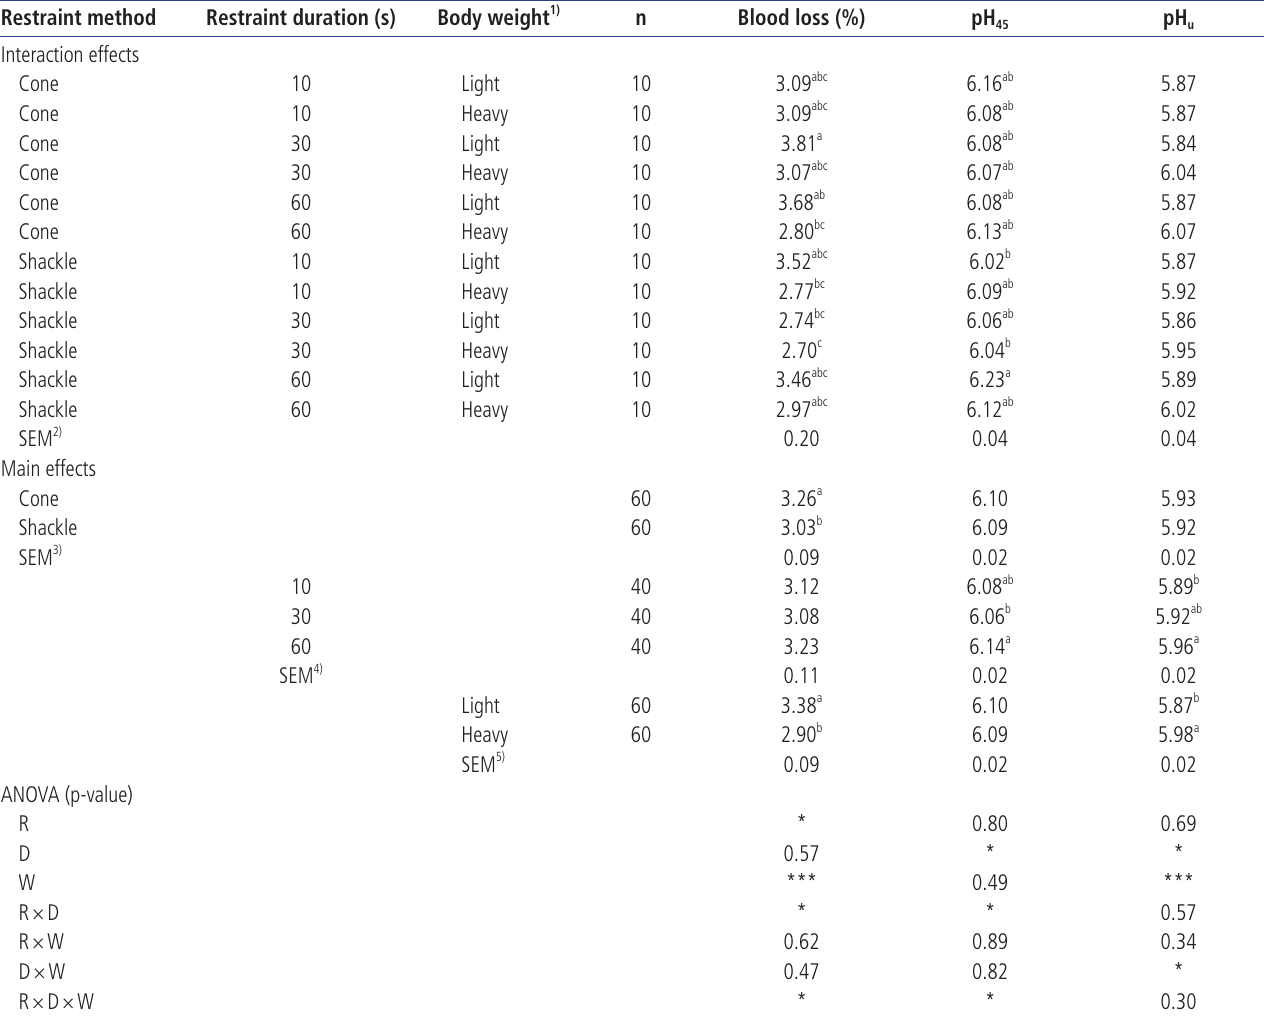
Table 2. Blood loss, breast muscle initial (pH broiler chickens Restraint